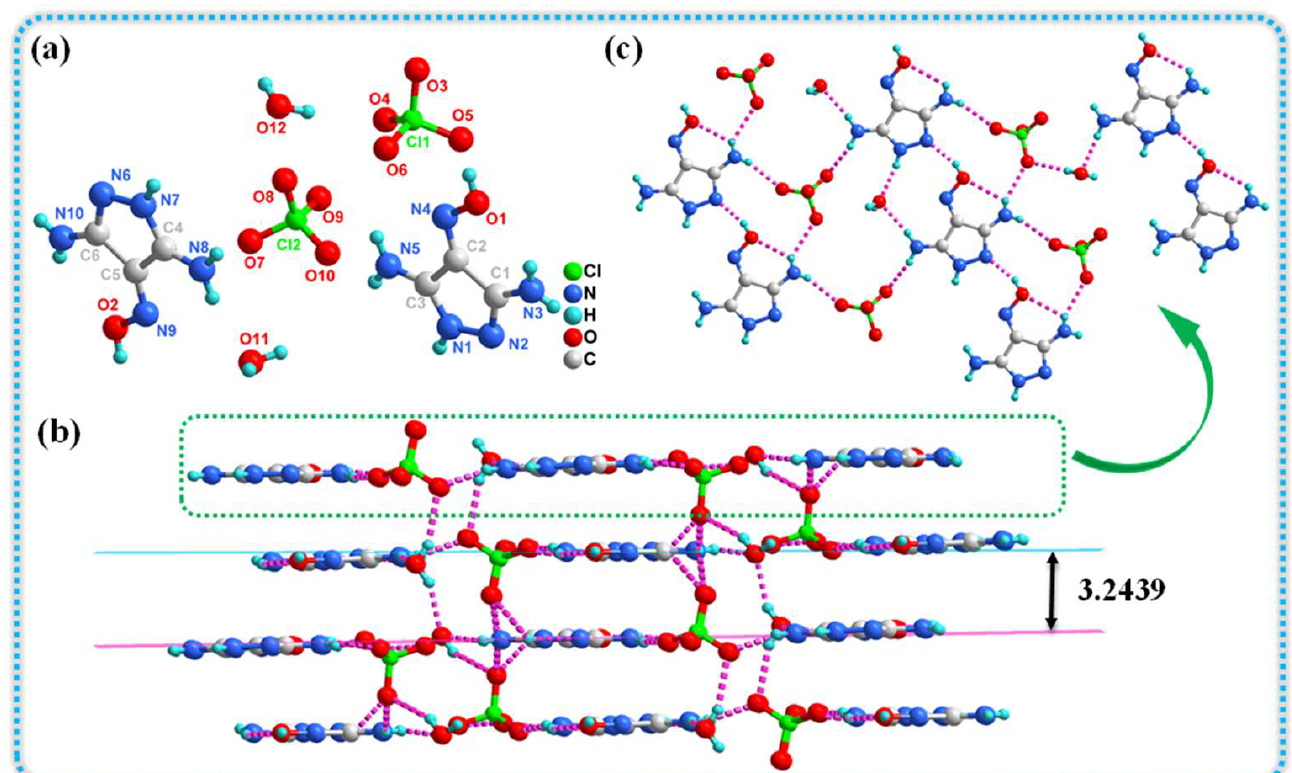
Figure 3. ( a ) Molecular structure of DAPOP·H 2 O; ( b ) Hydrogen bonding network of DAPOP·H 2 O; ( c ) Crystal stacking of DAPOP·H 2 O.